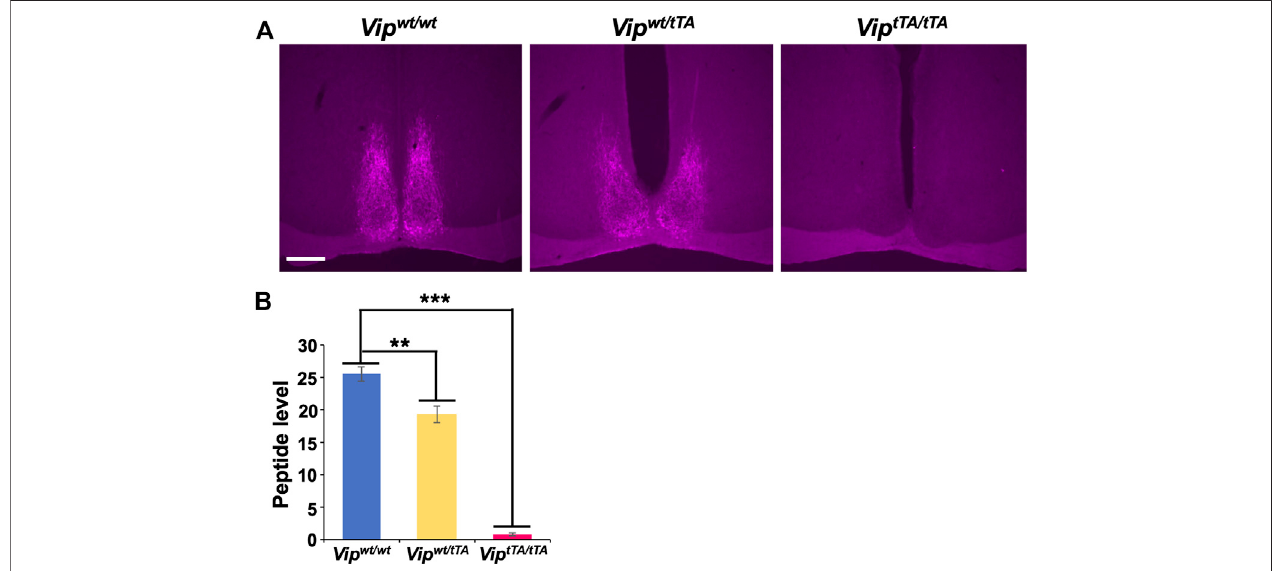
FIGURE 2 | VIP expression is absent in Vip tTA/ tTA mice. (A) Coronal brain sections containing the SCN prepared from Vip wt/wt , Vip wt/tTA , and Vip tTA/tTA mice were immunostained for VIP (magenta; scale bar, 200 μ m). Representative images are shown. (B) VIP immunostaining was slightly reduced in Vip wt/tTA (n = 4) compared to Vip wt/wt (n = 3) and almost absent in Vip tTA/tTA (n = 5) mice. Error bars indicate SEM. **, p < 0.005; ***, p < 0.001 by one-way ANOVA followed by post-hoc Tukey